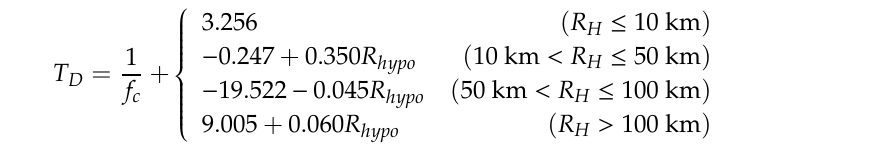
Figure 11. Estimated shaping window and duration for the 2017 Pohang earthquake: (a) Shaping window, (b) Duration with considering corner frequency.